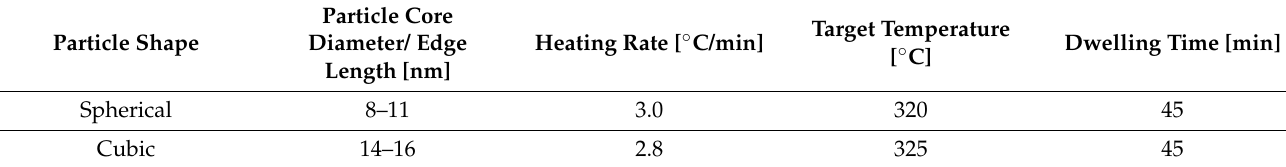
Table 1. The synthesis protocol for spherical- and cubic-shaped